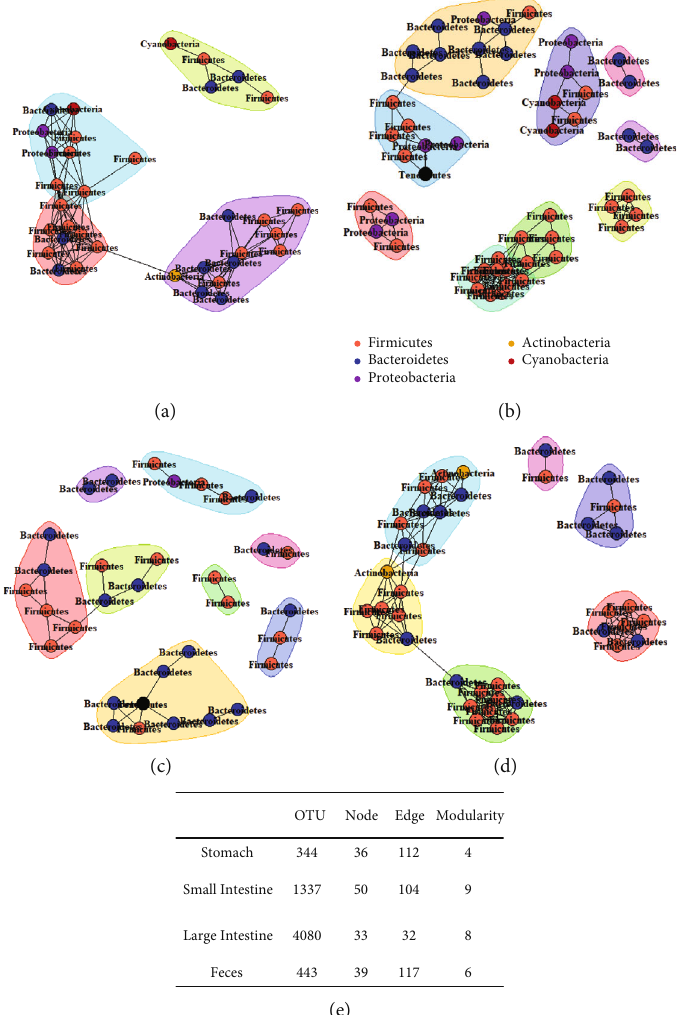
Figure 6: Cooccurrence network analysis of gut microbiome at the stomach (a), the small intestine (b), the large intestine (c) of the GI tract, and feces (d) with the ReBoot algorithm. The colored shapes represent network communities determined by the Louvain modularity algorithm. Node colors and labels represent phyla. (e) The network information of the gut microbiome at the stomach, the small intestine, the large intestine, and feces. OTU: the numbers of OTUs used for network analysis. Node: node numbers. Edge: edge number. Modularity: modularity number. The network was developed by using species-level